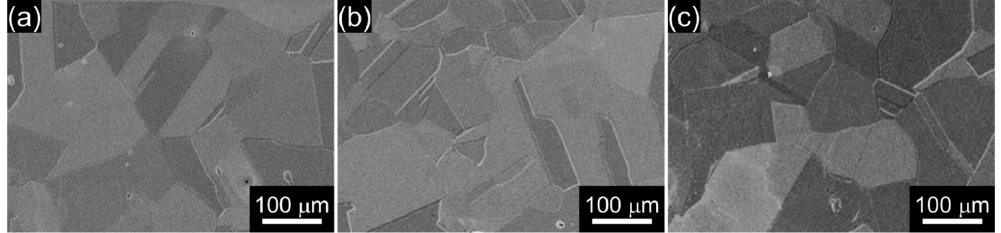
Figure 2. Microstructures of ( a ) 0Mo, ( b ) 1Mo, and ( c ) 2Mo alloys (SEM).